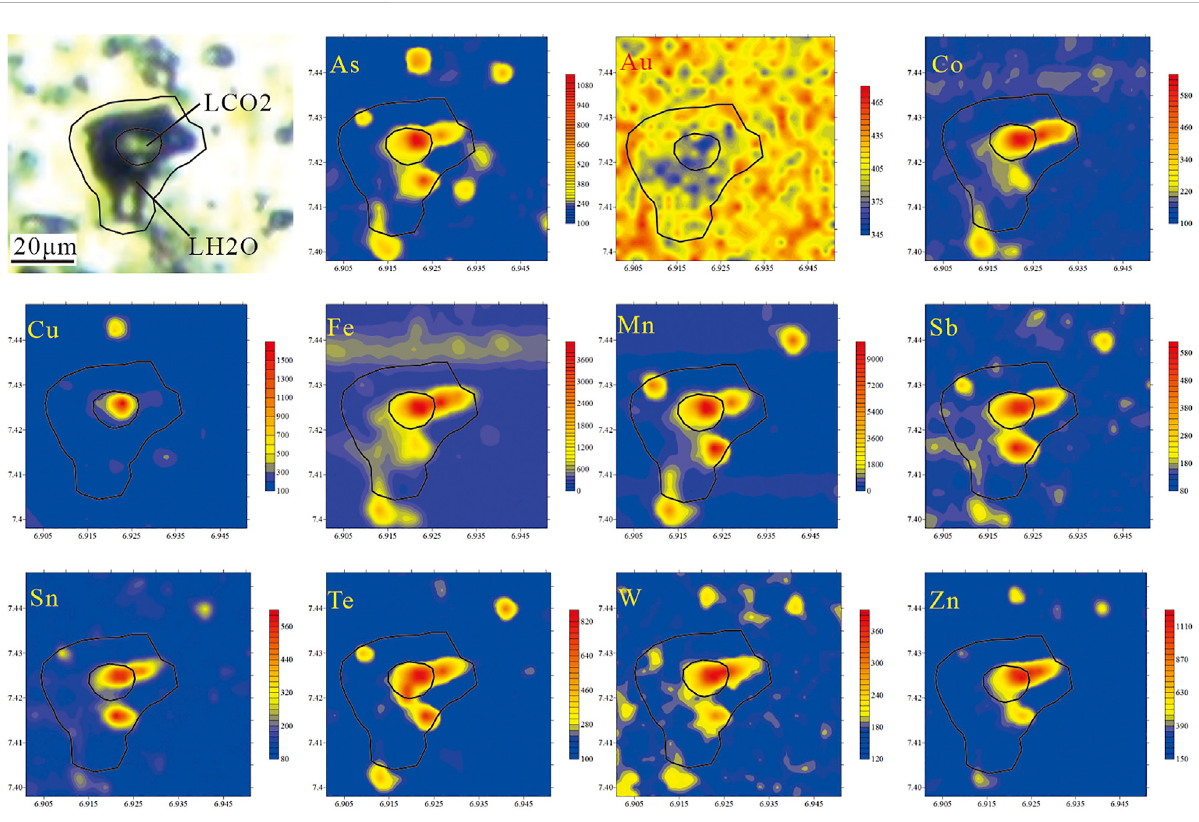
FIGURE 7 SRXRF mapping results of fl uid inclusions in gold-bearing quartz veins from the Dongtongyu gold deposit. Elements of As, Cu, Zn, Fe, Co, Mn, Te, Sb, Sn, and W are slightly concentrated, while Au is almost not enriched in the fl uid inclusion of the Dongtongyu gold deposit.